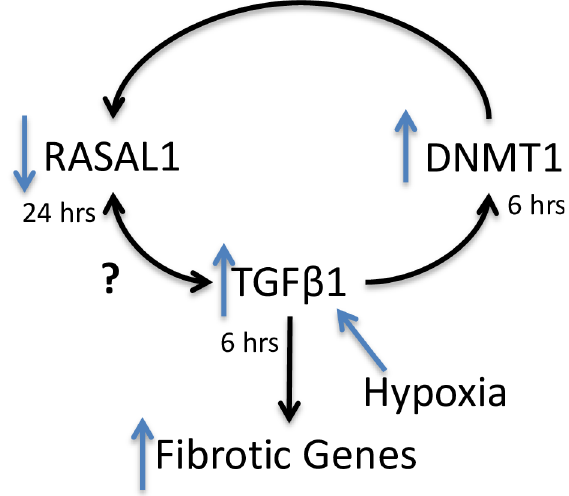
Fig 10. Hypoxia induces altered DNA methylation which alters the regulation of TGF β 1 and RASAL1. There is a previously established hypoxic environment in glaucoma[58]. Our hypothesis is that hypoxia increases TGF β 1 expression [70] and alters the DNA methylation profile of cells[44, 71]. TGF β 1 has a HRE which allows it to be regulated by HIF1 α , and hypoxia[72]. TGF β 1 has been shown to upregulate DNMT1 expression in fibroblasts[57]. Furthermore, TGF β 1 has been shown to downregulate RASAL1 directly, and has been shown to induce promoter hypermethylation of RASAL1 thorough DNMT1 in mouse renal fibroblasts[57]. However it has yet to be established if RASAL1 can also regulate TGF β